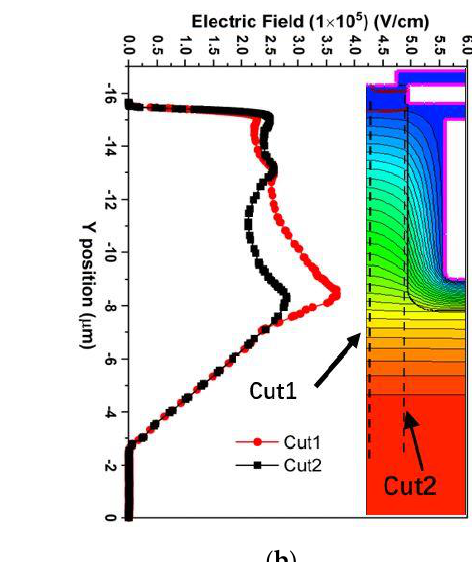
Figure 1. Cross section view of ( a ) split-gate resurf stepped oxide (SGRSO) and ( b ) split-gate resurf stepped oxide with high doped epitaxial layer (HDSGRSO) u-shape metal oxide semiconductor field e ff ect transistor (UMOSFET).